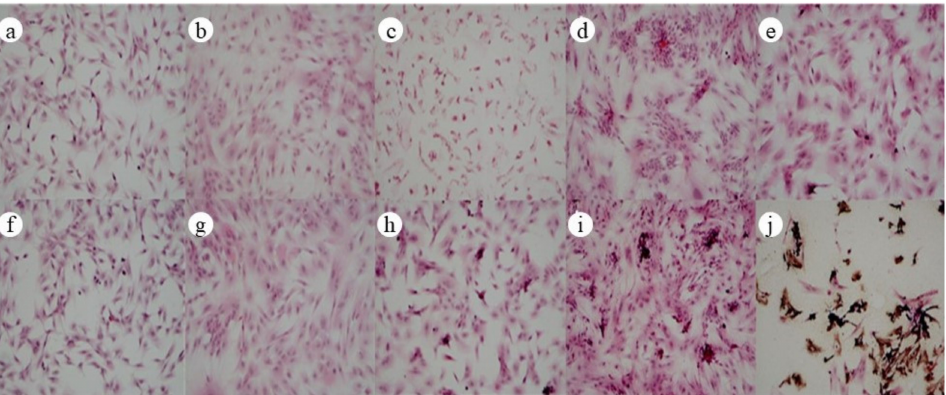
Figure 7. Staining images of cellular Von Kossa mineralized nodules in bone induction at different times ( a – e : the control group; f – j : the jawbones scaffold group) ( ×